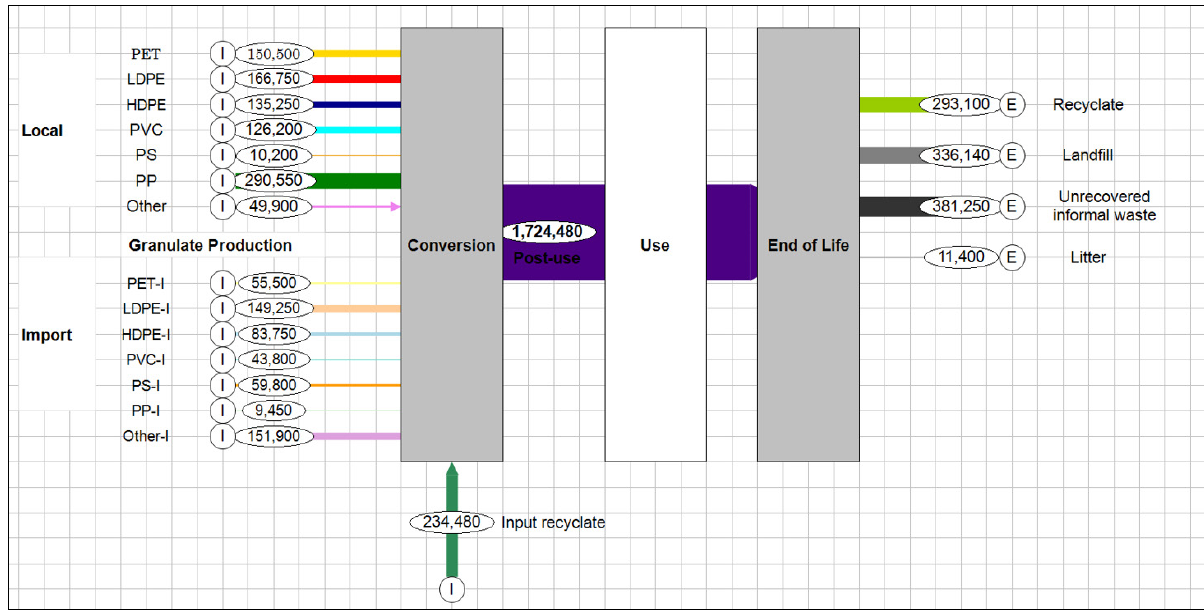
HDPE, high-density polyethylene; LDPE, low-density polyethylene; PP, polypropylene; PET, polyethylene terephthalate; PVC, polyvinyl chloride; PS, polystyrene Figure 1: Mass flows for the South African plastics system in 2015